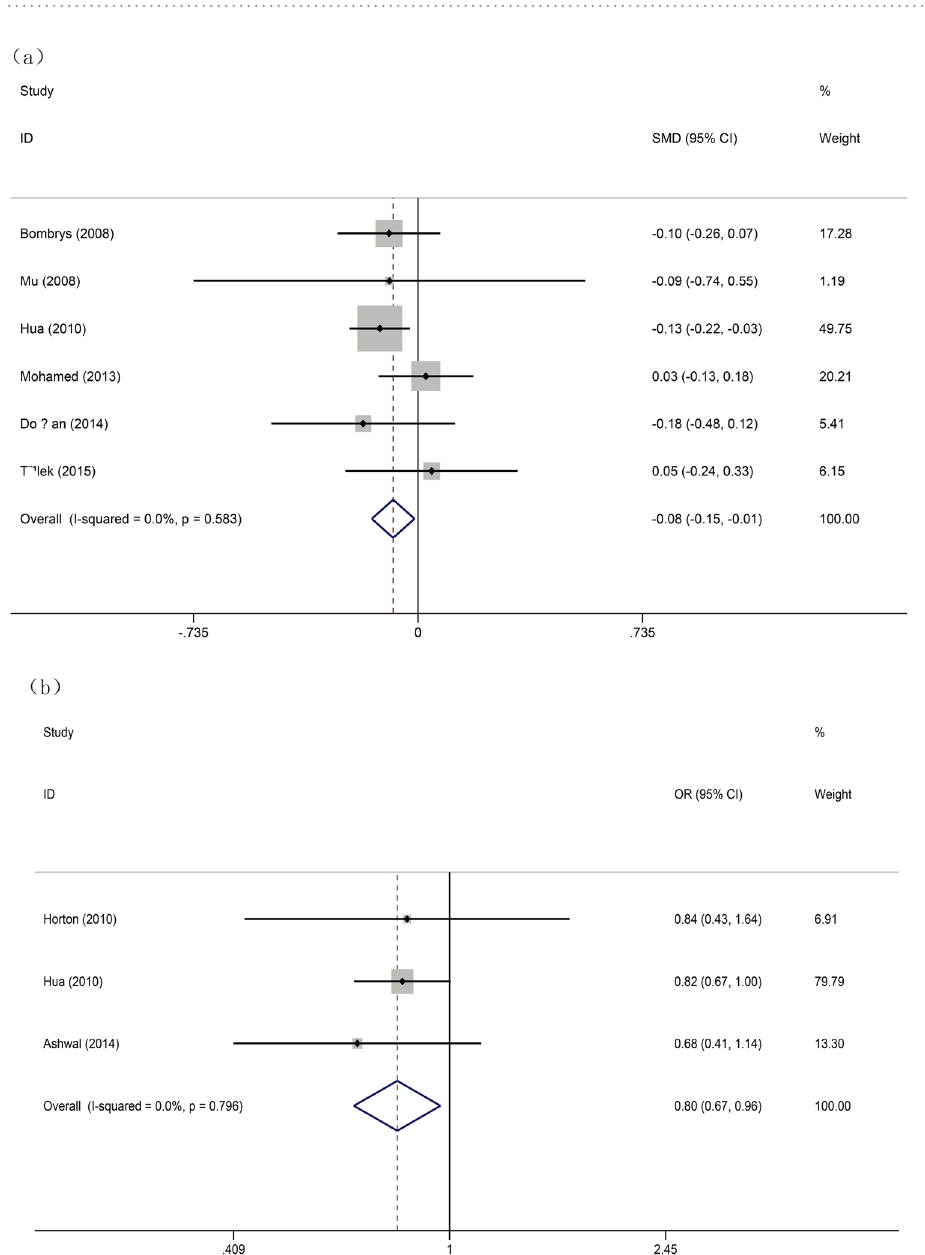
Figure 2. Forest plot of study evaluating the risk factors of iSUA: ( a ) maternal risk factor and ( b ) fetal risk